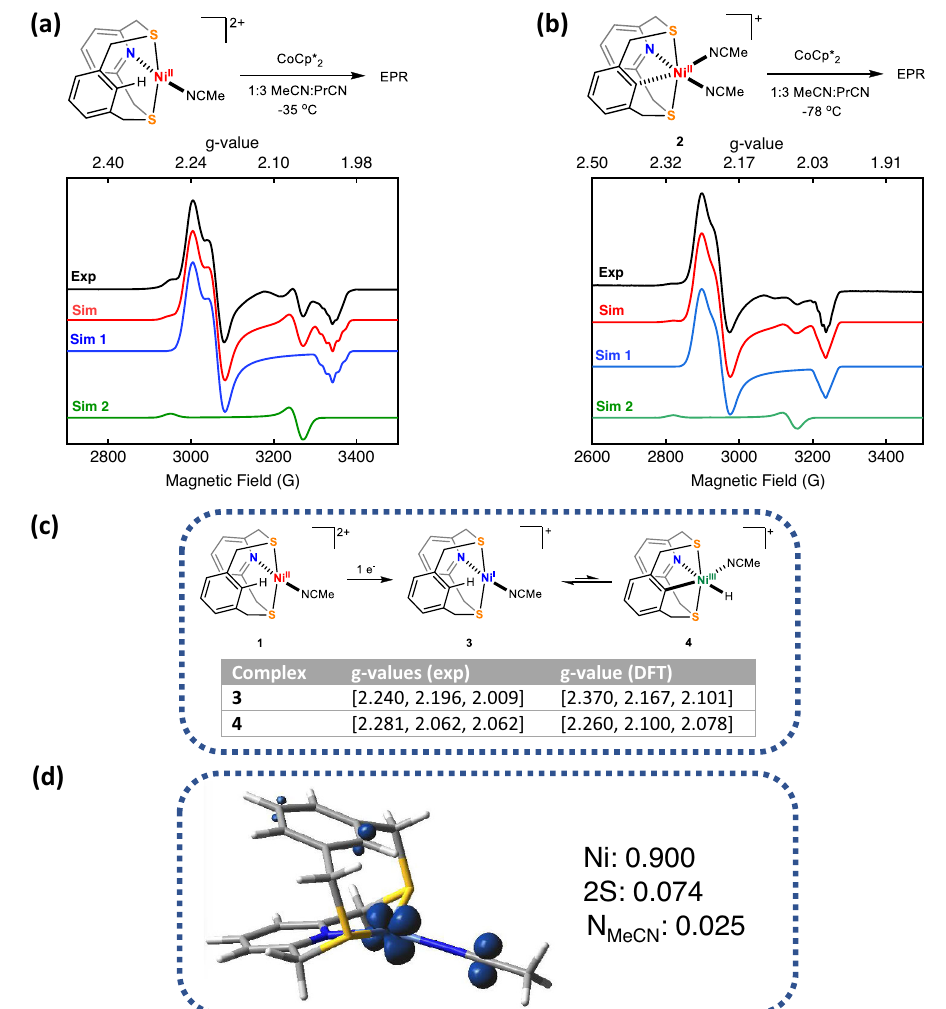
Fig. 4 | Chemical reduction of Ni II complexes. a, b Experimental (black) and simulated (red) EPR spectra for 1 and 2 after treating with 1 equiv. of Co II Cp* 2 in MeCN/PrCN(1:3)at77K.Forbothcases,thesimulatedspectra(red)employedtwo sets of parameters, Sim 1 (blue) and Sim 2 (green). The following parameters were used for the simulations: a Sim 1: g 1 =2.240 g 2 =2.196, g 3 =2.013 ( A 2N =15G),Sim 2: g 1 =2.281, g 2 =g 3 =2.062 b Sim1:g 1 =2.245g 2 =2.200,g 3 =2.009(A 2N =12G),Sim2: